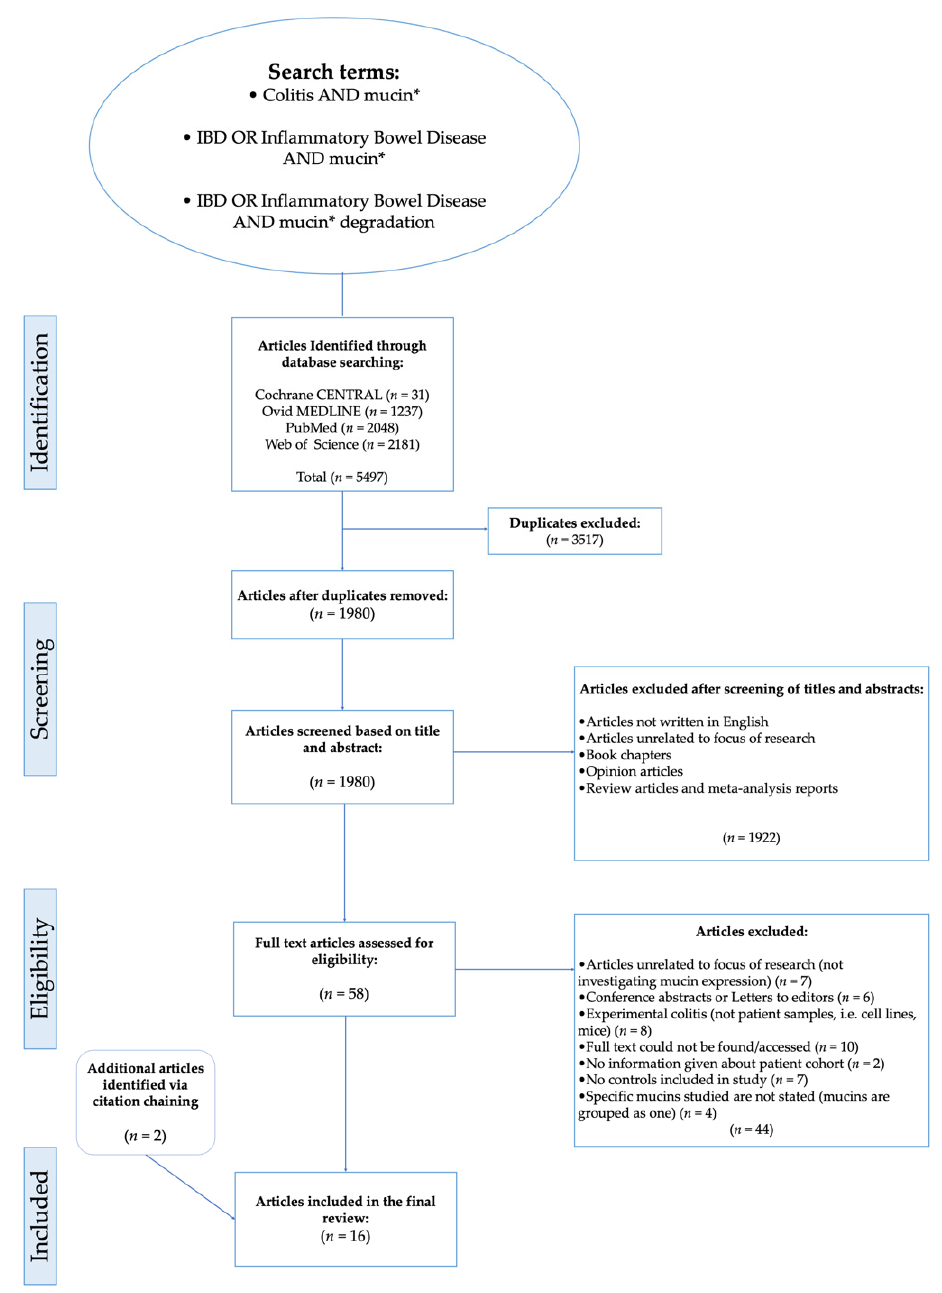
Figure 1. Flow chart showing steps of search process leading to the inclusion of articles for analysis. Boolean operators and search modifiers were using to optimise the retrieval of articles in the search strategy: ‘AND’ allows for citations containing all search terms to be retrieved, OR’ can produce citations containing at least one of a group of search terms. Therefore, ‘OR’ was used here where words were similar/related e.g. IBD and Inflammatory Bowel Disease. Truncation as denoted by asterix (*) was used to find citations including words with the same stem e.g. mucin, mucins,